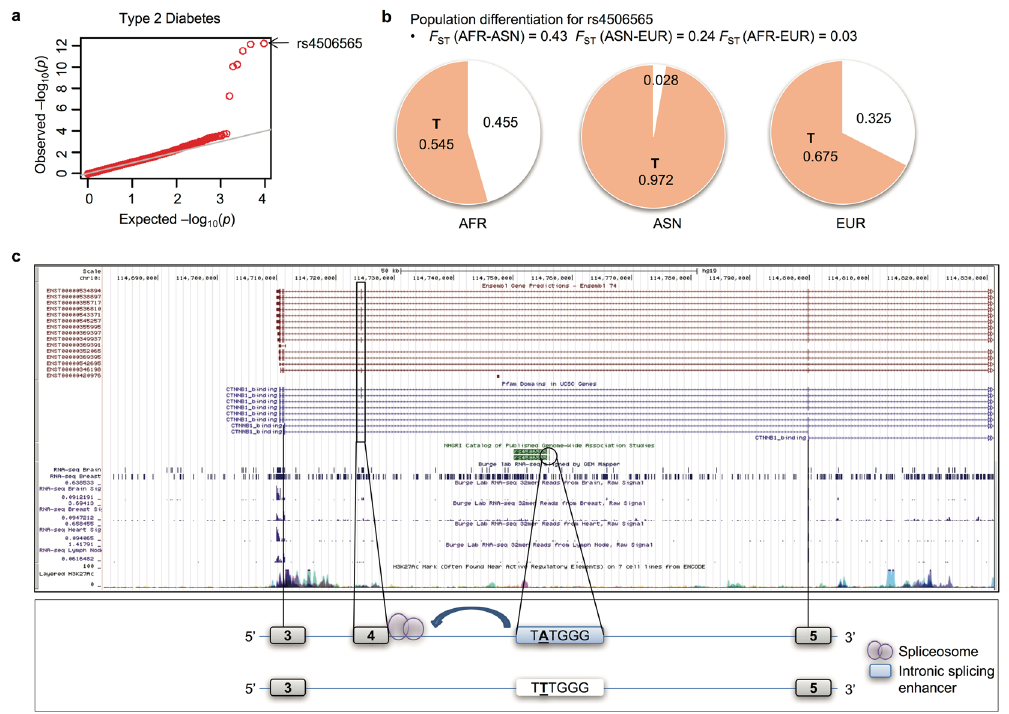
Figure 7. Disease susceptibility variant rs4506565 in TCF7L2 . ( a ) Significant association with Type 2 Diabetes. ( b ) rs4506565 is highly differentiated among populations and shows the highest F ST = 0.43 between AFR and ASN populations. ( c ) Model of exon skipping affected by rs4506565 in intronic splicing enhancer and impact of the skipped exon on protein domain